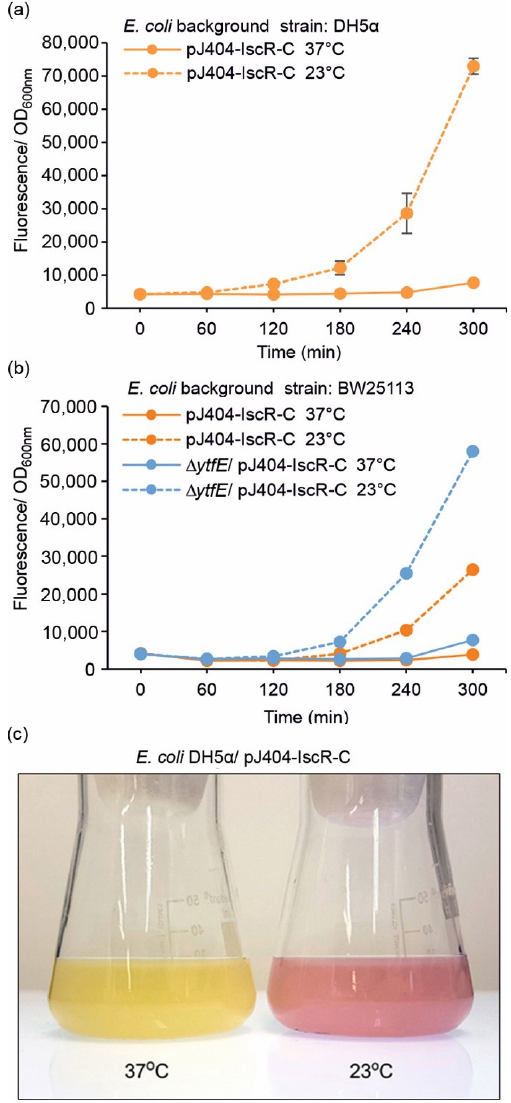
Figure 4. Fluorescence response of the pJ404-IscR-C sensor system towards lowered cultivation temperature in ( a ) DH5α and ( b ) BW25113 background (see Table 1 for strain details). Fluorescence was measured at one-hour intervals from cultures grown at the default temperature of 37 °C (solid lines) or 23 °C (dashed line). The averages and standard deviations were calculated based on three independent parallel cultures with three technical replicates each ( n = 9). Due to small standard deviations, the error bars are not always visible. ( c ) Visualisation of the red fluorescence response triggered by lowered cultivation temperature, as observed directly from parallel flask cultures of the generated E. coli reporter strain DH5α /pJ404-IscR-C incubated at 37 °C (left) and 23 °C (right) for 18 h after induction.